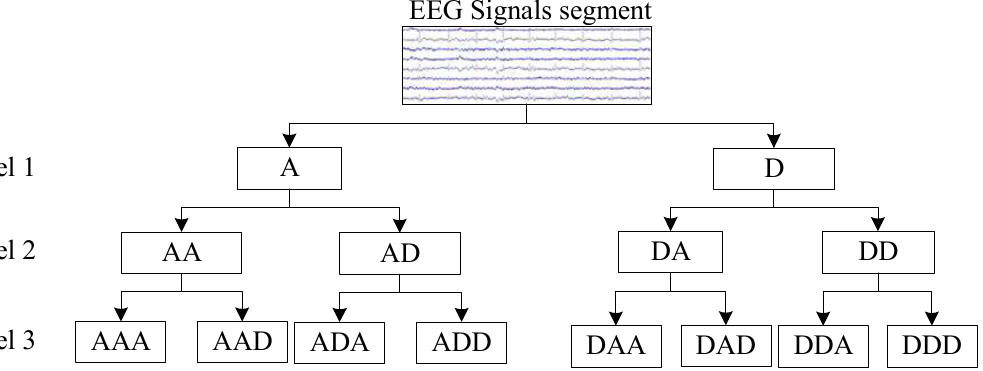
Figure 3. The structure of 3-level